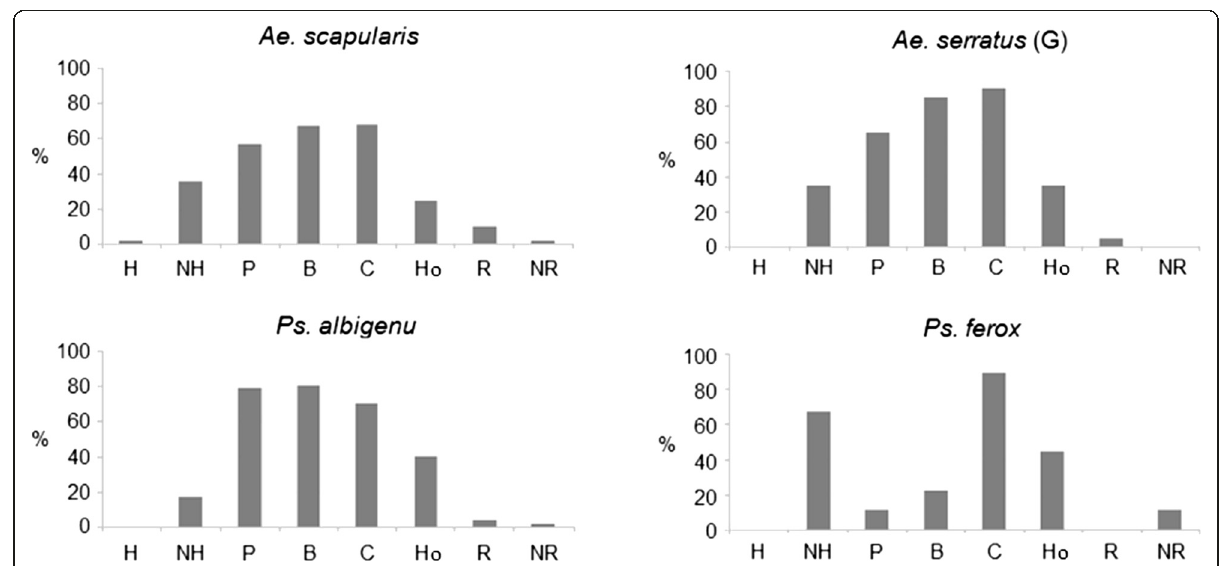
Figure 2 Percentages of blood-source types for most abundant species of the total processed, by species. H: human (exclusive), NH: non-human primate (exclusive), P: primate (human + non-human), B: bird, C: cow, Ho: horse, R: rat and NR: not reagent. Aedes serratus (G): group including Ae. serratus and Ae. serratus/aenigmaticus